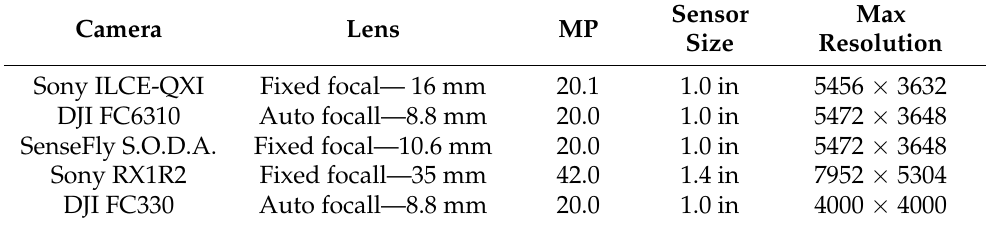
Table 2. Camera’s